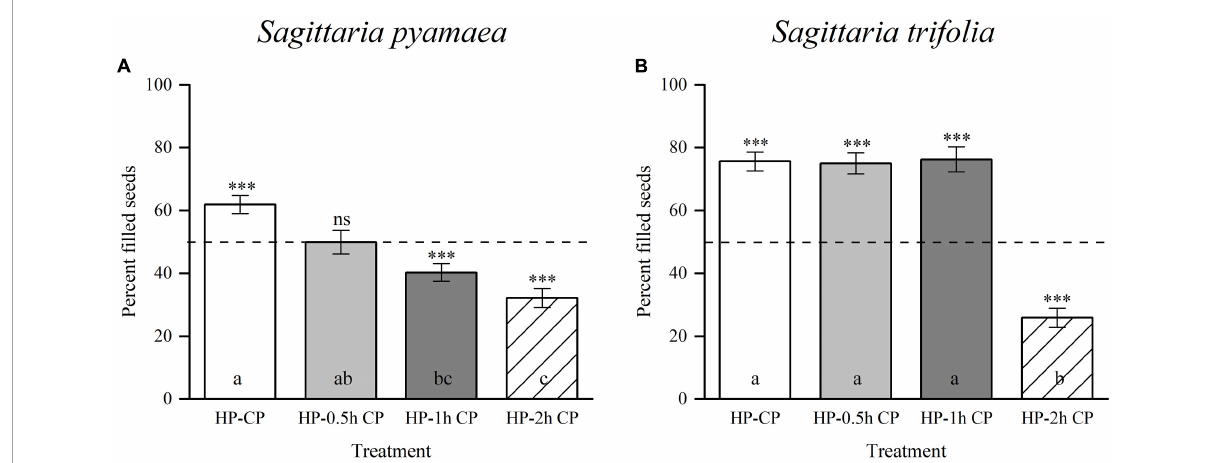
FIGURE4 Percentages of filled seeds produced by hand-pollination experiments in which the maternal parent first received HP and later CP in Sagittaria pygmaea and S. trifolia . (A) S. pygmaea and (B) S. trifolia : HP-CP (sequence first HP then CP immediately), HP-0.5 h CP (sequence first HP 0.5 h later CP), HP-1 h CP (sequence first HP 1 h later CP) and HP-2 h CP (sequence first HP 2 h later CP). Asterisks show that the percentage of filled seeds is significantly differences from 50% (dashed line). (ns, not significant; ∗∗∗ p < 0.001). Different letters indicate significant